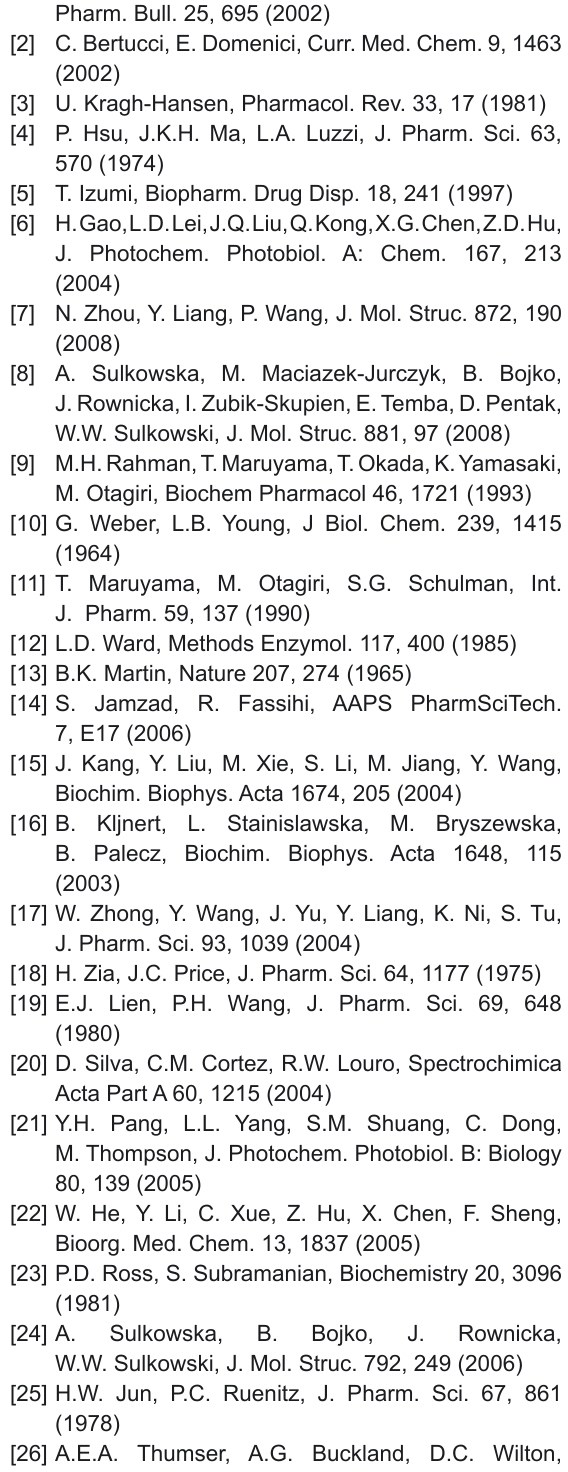
Glipizide was found to have higher binding affinity for serum albumin than glimepiride at all